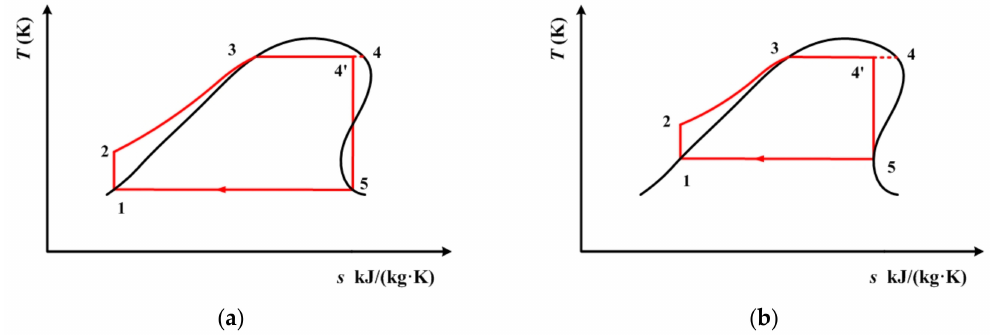
Figure 6. Subcritical ORC for cis-butene with a single-screw expander when the condensation temperature is known: ( a ) 290 K, ( b ) 320